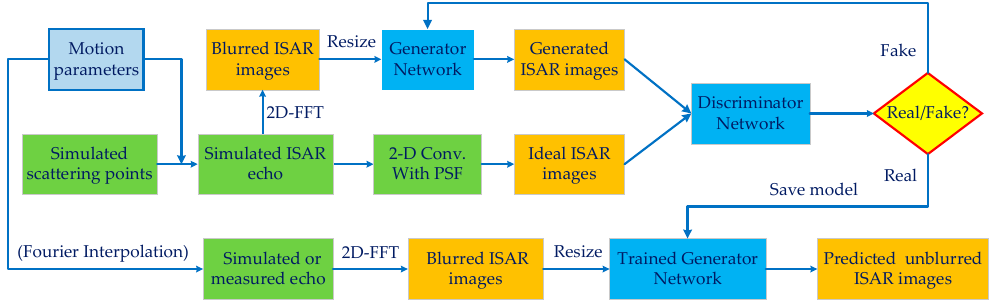
Figure 2. ISAR imaging framework for maneuvering target.